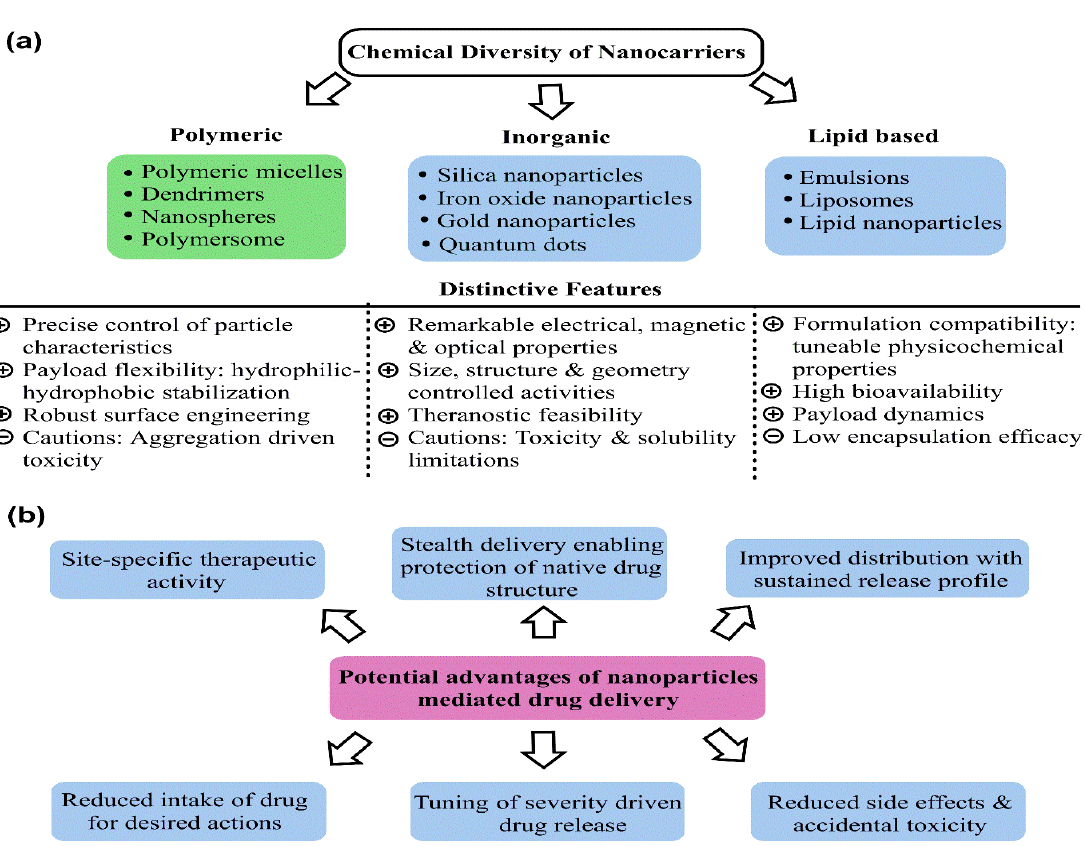
Figure 2. ( a ) Distinctive prospects of the various nanoparticles used as drug delivery carriers, and ( b ) Exclusive advantages of using nanoparticles as drug vehicles, reducing the risk of chemo-resistance.